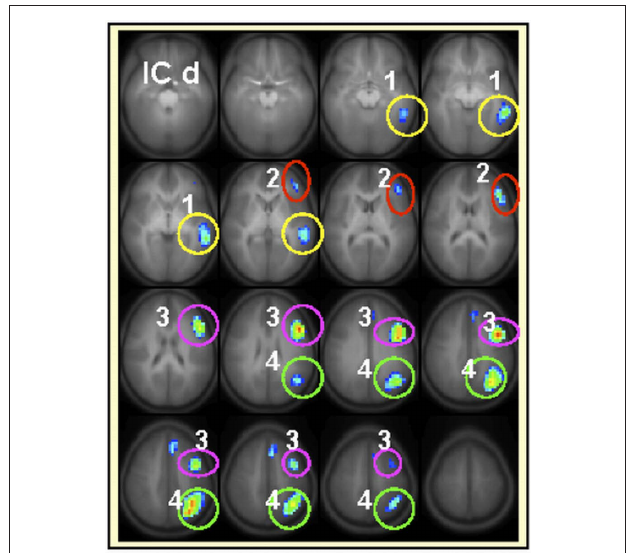
FIguRe 3 | Regions included (only the active areas) in the intra- component functional connectivity analysis for IC d are 1 medial temporal gyrus (LMTg), 2 inferior frontal gyrus (LIFg), 3 middle inferior frontal gyrus (LMIFg), 4 angular gyrus (LANg). Each brain region will be represented by the average activation within that ROI across time. Slice range: Z = − 25 to + 50 mm (Talairach coordinates). All images are in radiologic orientation (left in the picture is right in the brain).